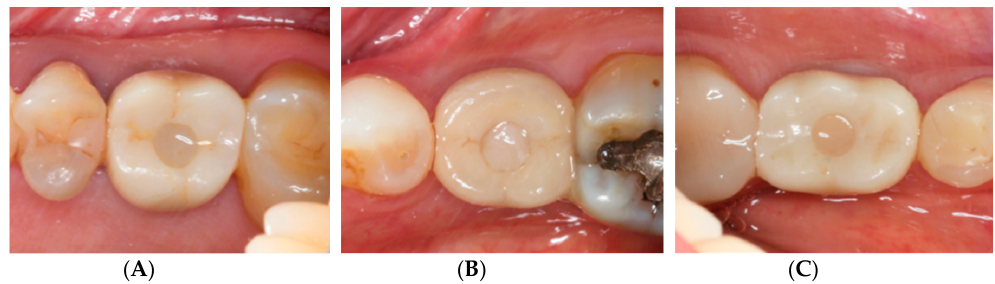
Figure 6. Clinical cases at T4 demonstrating ( A ) no alveolar process deficiency; ( B ) slight alveolar process deficiency; ( C ) obvious alveolar process deficiency.